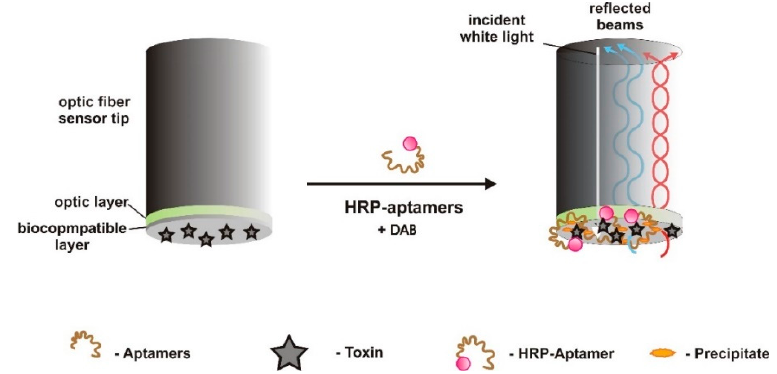
Figure 13. Real-time optical biosensor developed by Gao et al. [62] for palytoxin (PTX) detection, using coupled biolayer interferometry (BLI) and an enzyme-linked aptamer in a competitive binding assay. Binding events shift the interference spectrum of the reflected light. After being in contact with the sample, the biosensor tip with the PTX:HRP-aptamer complex attached was immersed in a 3,3 ′ -diaminobenzidine (DAB) solution, resulting in the formation of a precipitate on the sensors surface, with subsequent signal amplification. HRP-horseradish peroxidase.